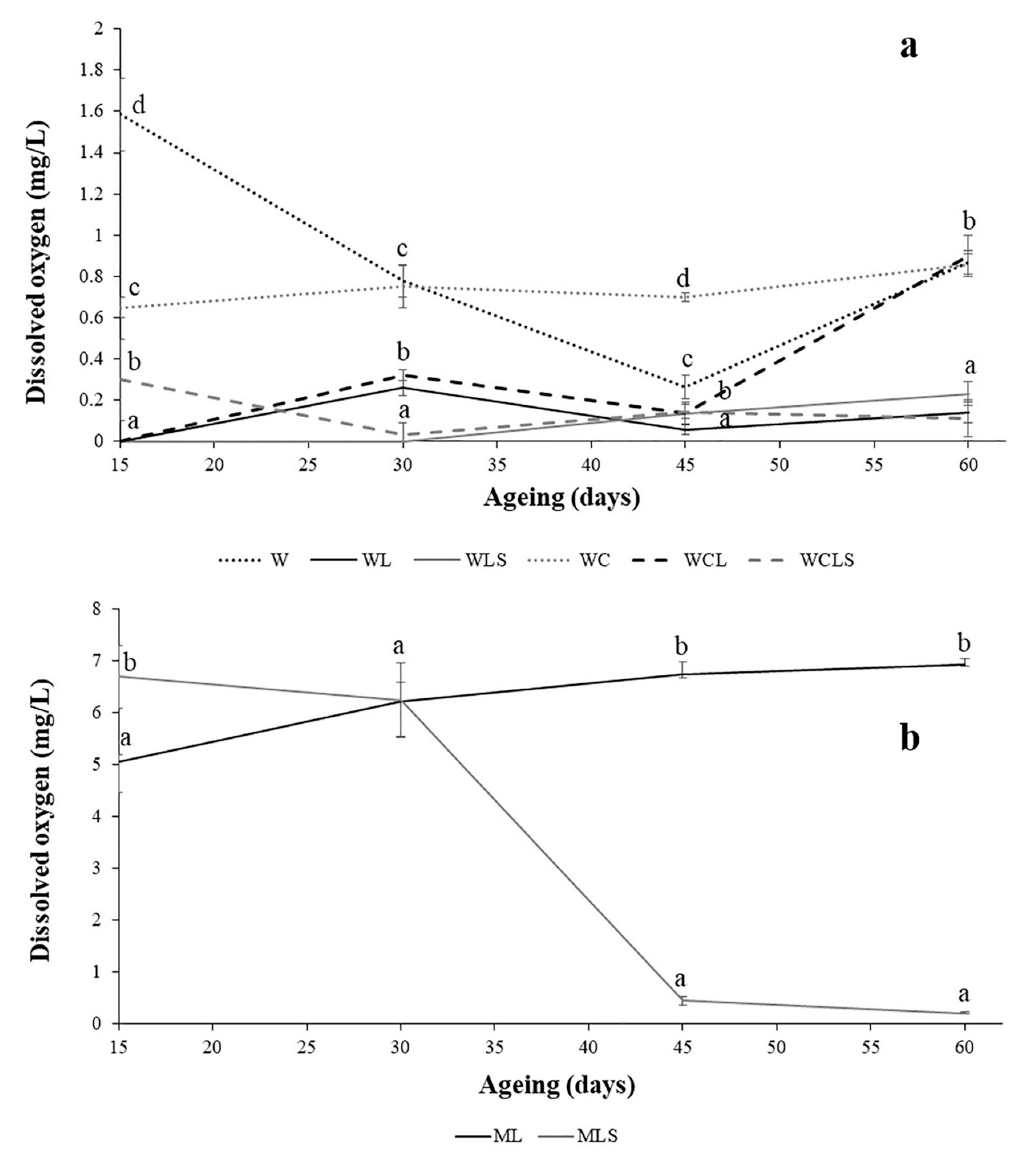
Figure 2. Dissolved oxygen content (mg/L) throughout the AOL, in red wines ( a ) and in the hydroalcoholic solution ( b ). W—control wine; WL—wine with lees; WLS—wine with sonicated lees; WC—wine with oak chips; WCL—wine with lees and oak chips; WCLS—wine with sonicated lees and oak chips; ML—hydroalcoholic solution with lees; MLS—hydroalcoholic solution with sonicated lees. Mean ± standard deviation of the three replicates. Different letters in axes X indicate values with statistical significant differences ( p < 0.05).